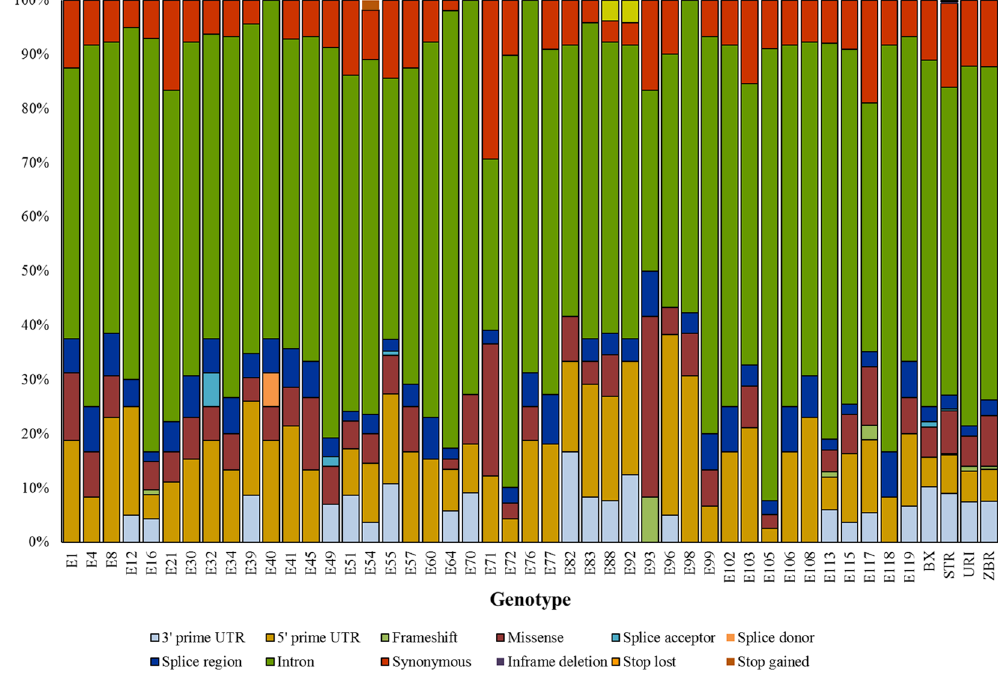
Figure 5. Stacked bar chart showing sequence changes grouped by SnpEff categories within gene regions.